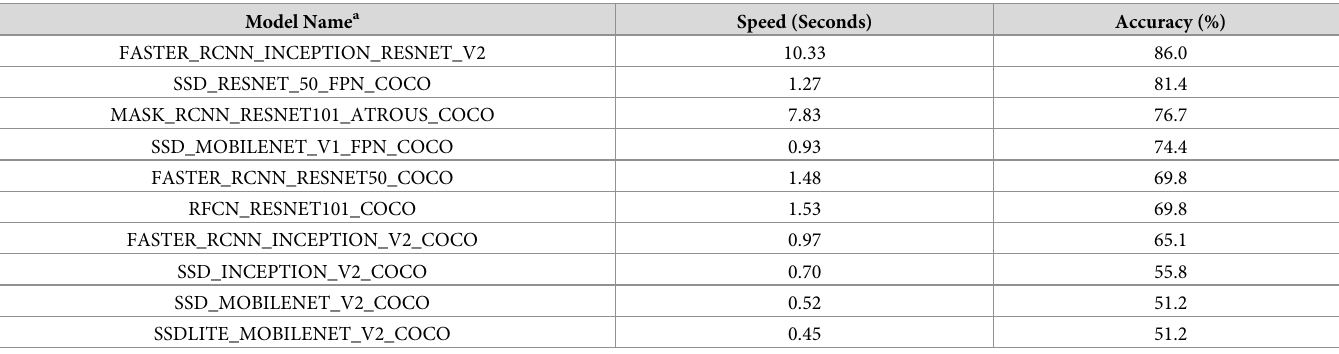
Table 3. Comparison of deep convolutional neural network